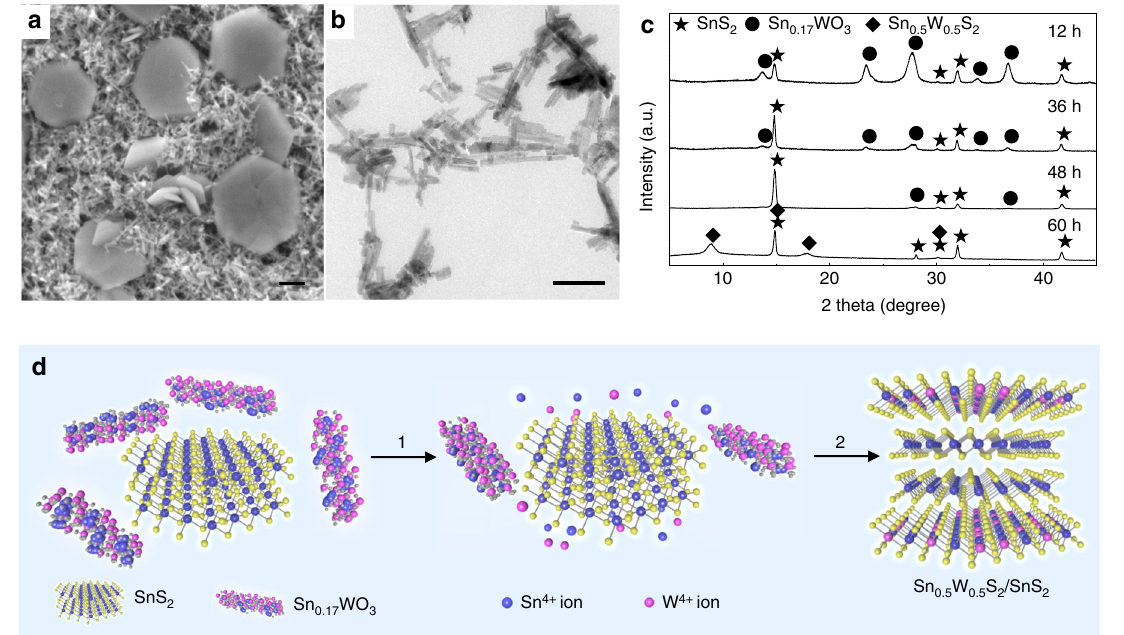
Fig. 3 Formation process of Sn 0.5 W 0.5 S 2 /SnS 2 heterostructures. a SEM image of the intermediate product obtained after the reaction proceeded for 12 h (scale bar, 200 nm). b TEM image of typical Sn 0.17 WO 3 nanorods (scale bar, 100 nm). c XRD patterns of the intermediate products obtained at different reaction intervals. d Schematic illustration of the formation process of Sn 0.5 W 0.5 S 2 /SnS 2 heterostructures. SnS 2 nanoplates and Sn 0.17 WO 3 nanorods formed together during the initial 12 h. After that the Sn 0.17 WO 3 nanorods began to decompose (step 1), providing additional W and Sn ions for Sn 0.5 W 0.5 S 2 nanosheets to grow on the surfaces of the SnS 2 nanoplates (step